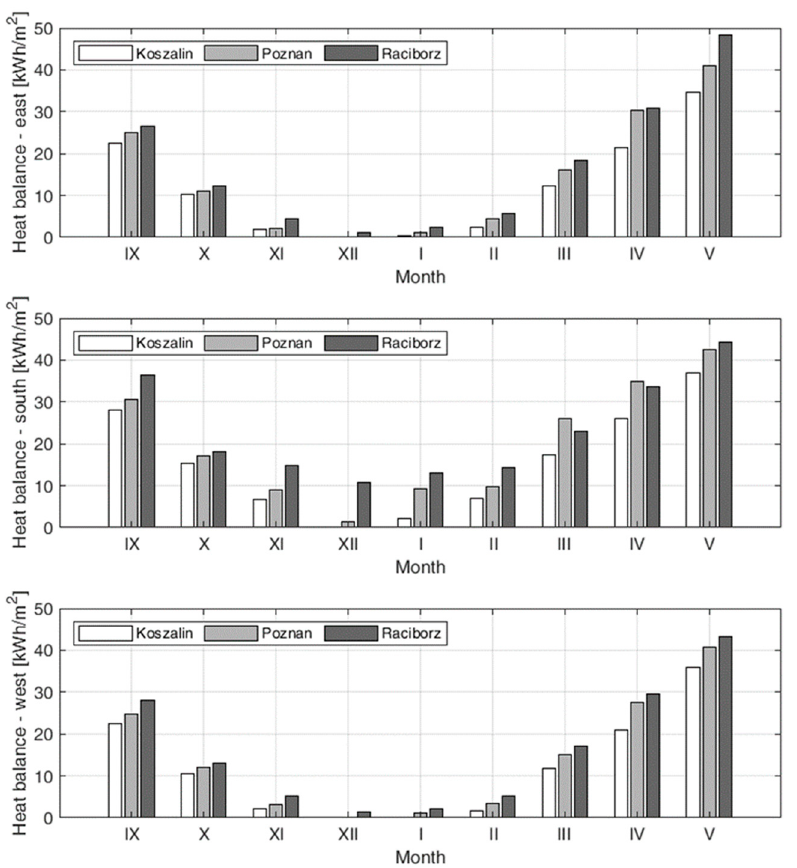
Figure 15. Comparison of monthly heat balances of an SW-TI with the insulation thickness of 108 mm located in different parts of Poland for eastern (top graph), southern (graph in the middle), and western (bottom graph) orientation.